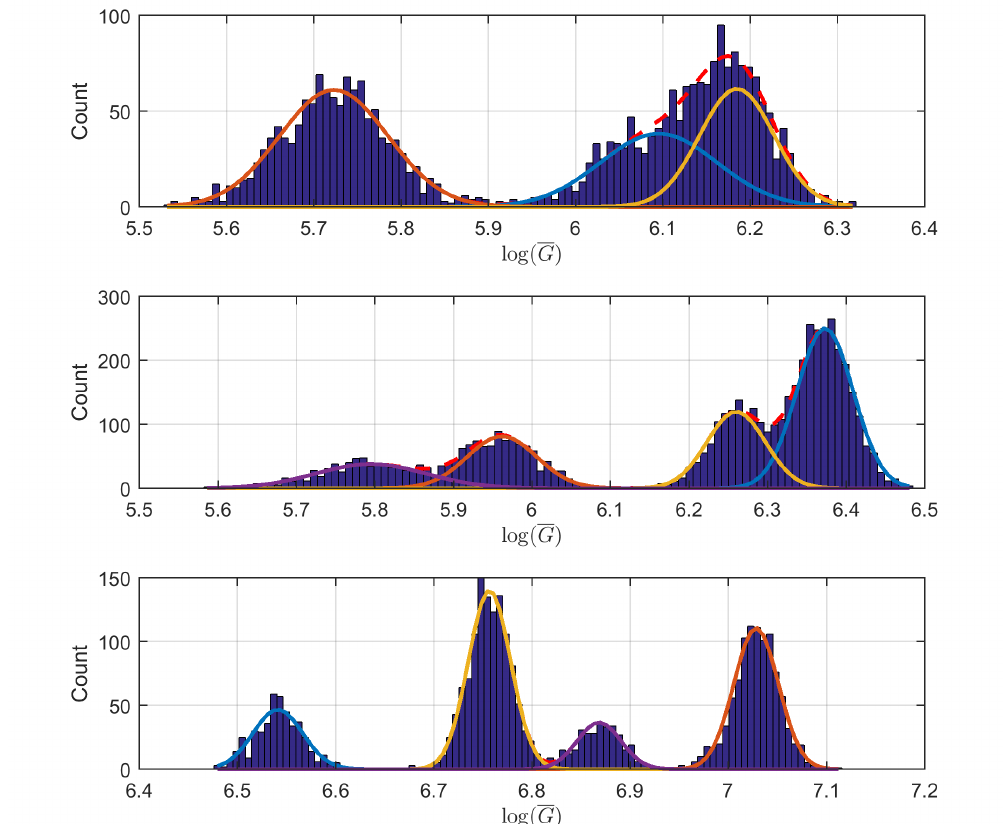
Figure 7. Sample results of fitting log G with Gaussian Mixture